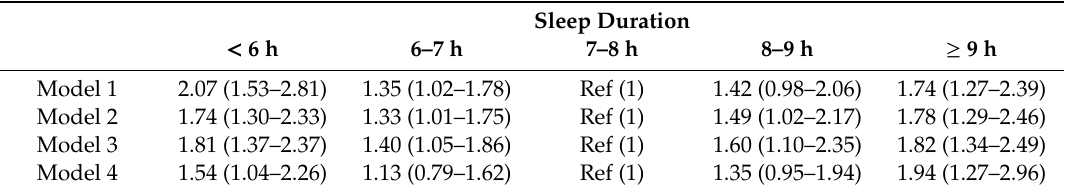
Table 3. Odds ratio and 95% confidence intervals for higher serum uric acid ( > 5.6 mg / dL) according to sleep